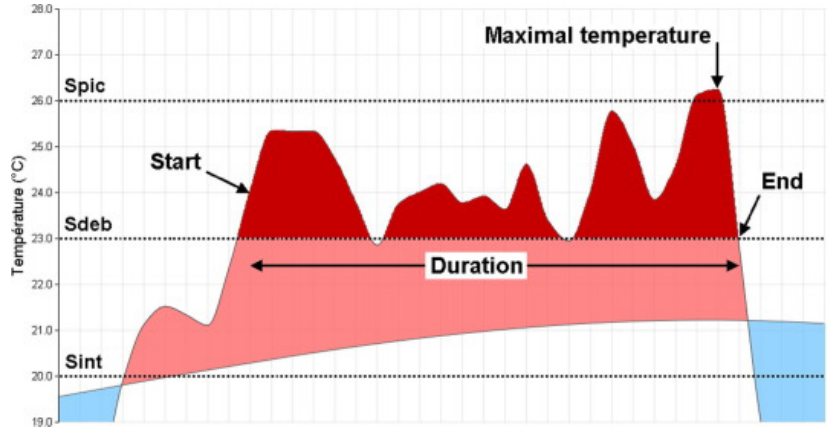
Figure 4. Figure and legend from Ouzeau et al. (2016): characterisation of a heatwave from a daily mean temperature indicator over France (example of a time series from 30 June to 5 August 1983). Duration (start and end), maximal temperature, and global intensity (red area of the plot). Temperatures above (below) the climatological line (1981–2010 reference period) are represented by the pink (blue) area. (For an interpretation of the references to colour in this figure legend, the reader is referred to Ouzeau et al.,